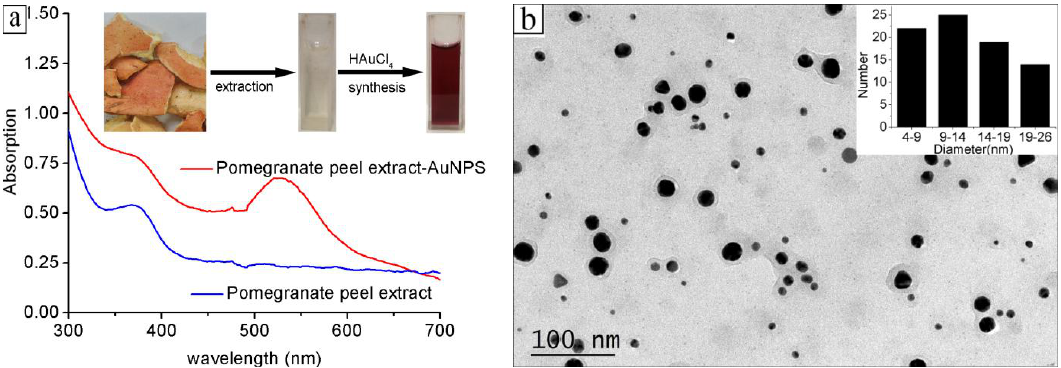
Figure 1. ( a ) UV-Vis absorption spectra of the water extract of pomegranate peels and the synthesized gold colloid in a typical experiment; ( b ) The representative TEM image of the obtained gold nanoparticles. Figure 2a shows the UV-Vis absorption spectrum of the